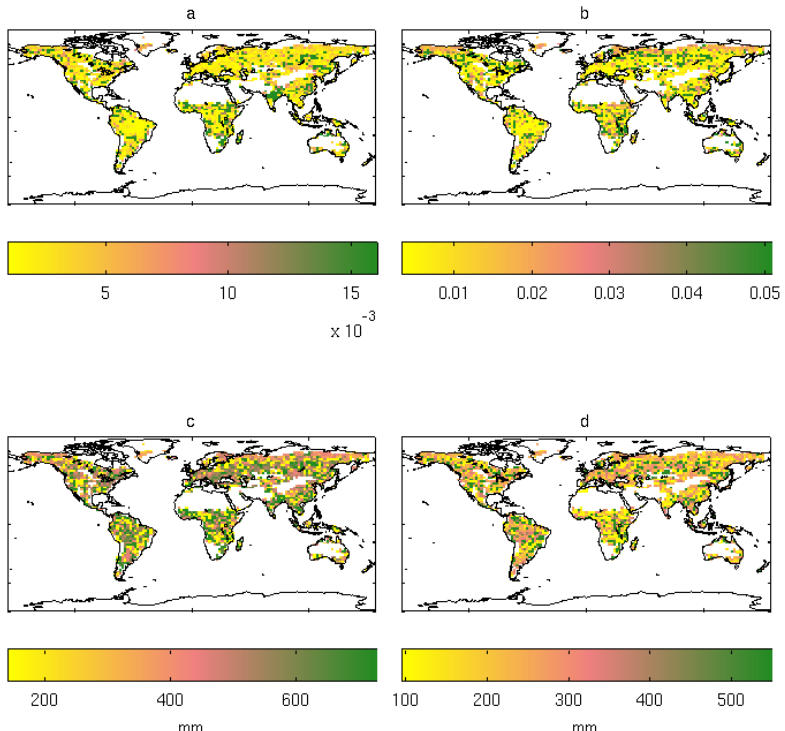
Fig. A2. Posterior parameter values describing soil water effects: (a, b) soil water extraction parameters s 1 and s 2 , (c) water use u and (d) evapotranspiration rate